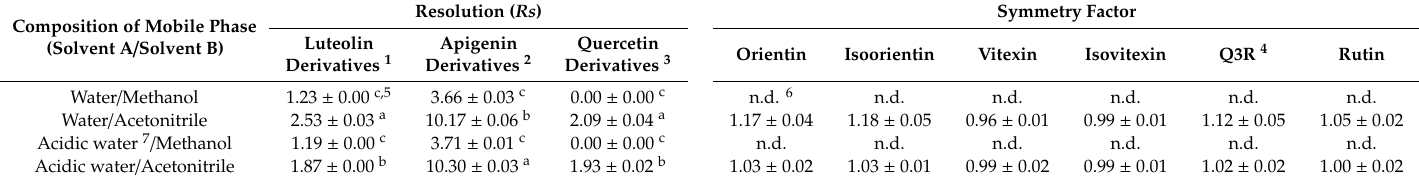
Table 1. E ff ect of the mobile-phase composition on the separation of isomers in common buckwheat sprout